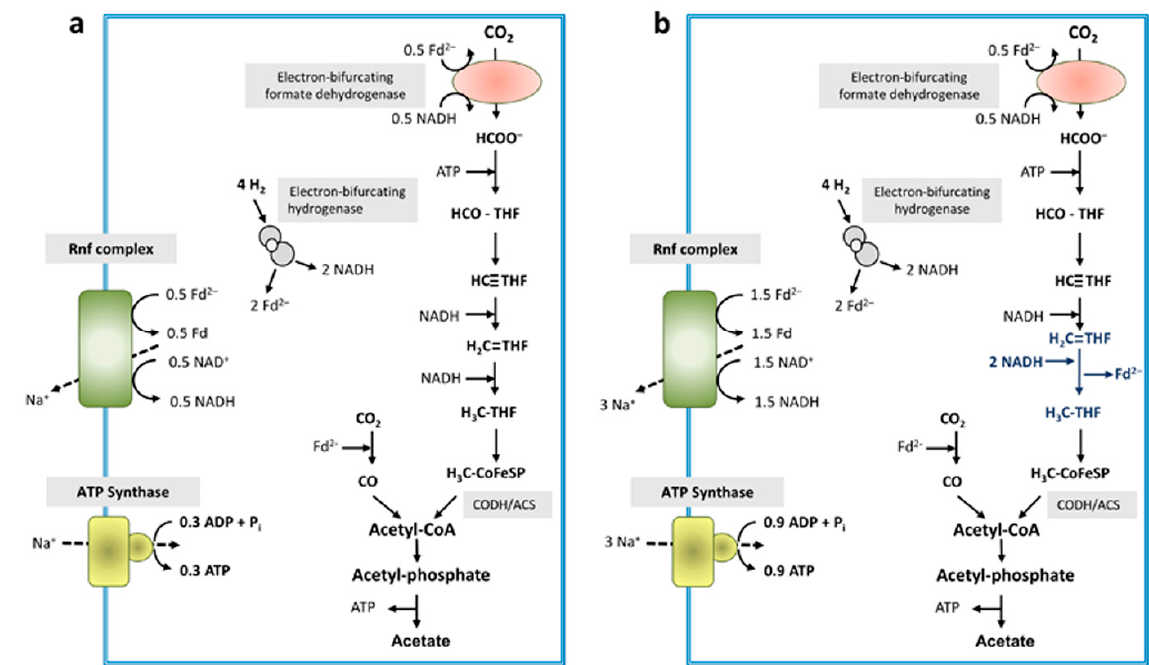
Figure 8. Schematic overview of energy conservation during acetogenesis from H 2 + CO 2 in C. aceticum . The electron- bifurcating hydrogenase converted 4 mol of H 2 to 2 mol reduced ferredoxin and 2 mol NADH. Then, 0.5 mol of reduced ferredoxin together with 0.5 mol NADH are used by the electron-bifurcating formate dehydrogenase to reduce 1 mol of CO 2 to formate. Formate gets further reduced to methyl-THF via several reduction steps: if the methylene-THF reductase uses only NADH as reductant ( a ), 2 mol NADH are required to reduce methenyl-THF to methyl-THF, whereas 3 mol NADH would be required if the methylene-THF reductase is electron bifurcating ( b ), which leads to the reduction of another mol of ferredoxin. After condensation of methyl-THF and 1 mol CO 2 by the CODH/ACS, acetyl-CoA is further converted to acetate. For energy conservation the Rnf complex in concert with the ATP synthase are used. A Na + /ATP stoichiometry of 3.3 as in A. woodii [43] is assumed. Depending on the mode of operation of the methylene-THF reductase, either 0.3 or 0.9 mol ATP can be generated. Fd, ferredoxin; THF, tetrahydrofolate; CoFeSP, corrinoid iron-sulfur protein.